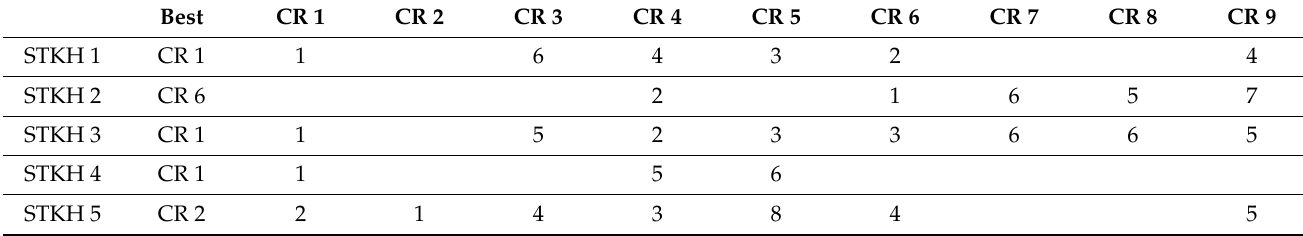
Table A4. Preference values assigned to criteria by stakeholders.